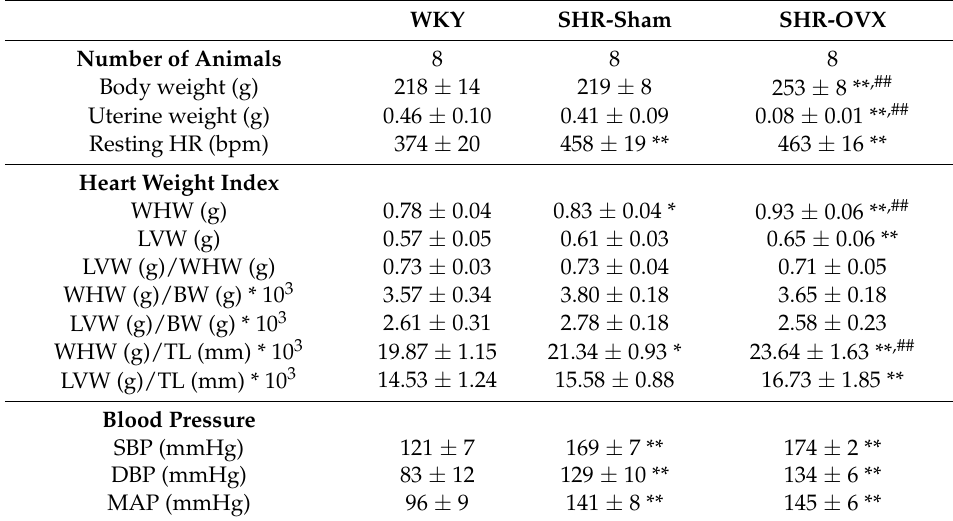
Table 1. Cardiac characteristics of WKY, SHR-Sham and SHR-OVX groups. WKY SHR-Sham SHR-OVX